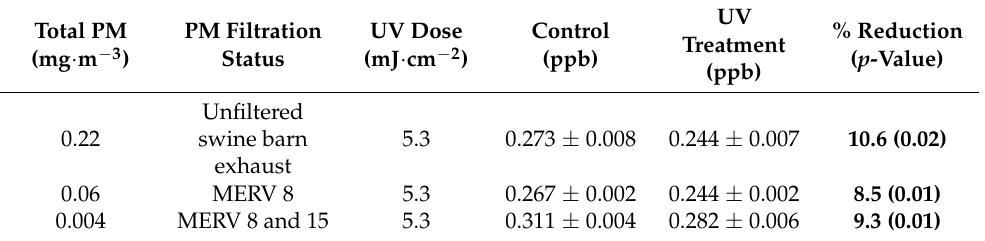
Table 9. Performance of UV-A photocatalysis in mitigating N 2 O concentrations under different PM